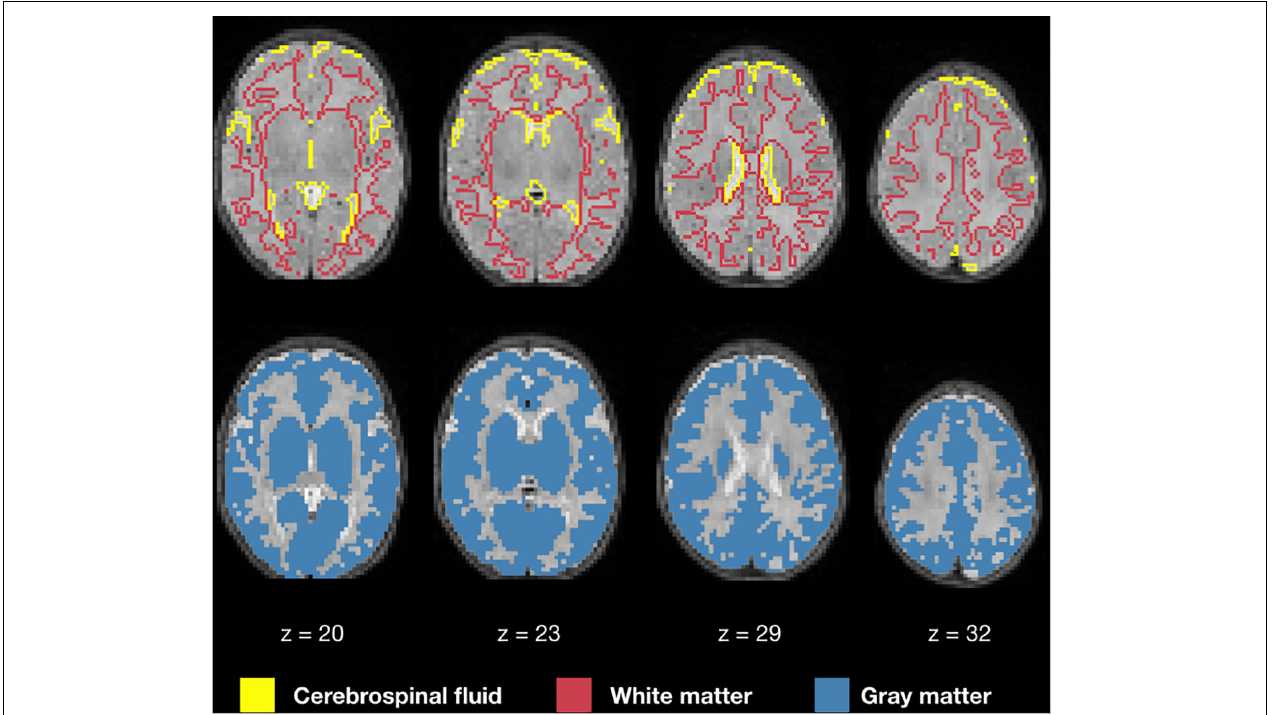
FIGURE 7 | White matter, cerebrospinal fluid, and gray matter masks for regression of confounds.